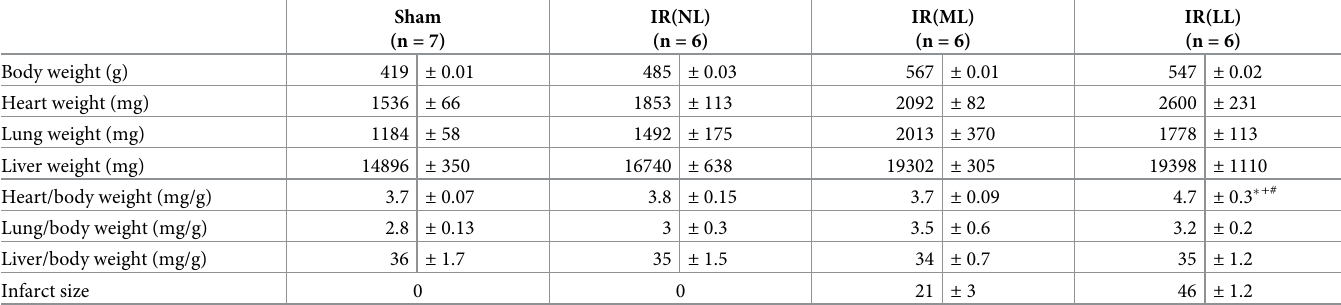
Table 1. General characteristics of rats 4 weeks after acute myocardial ischemia-reperfusion (IR) or sham surgery